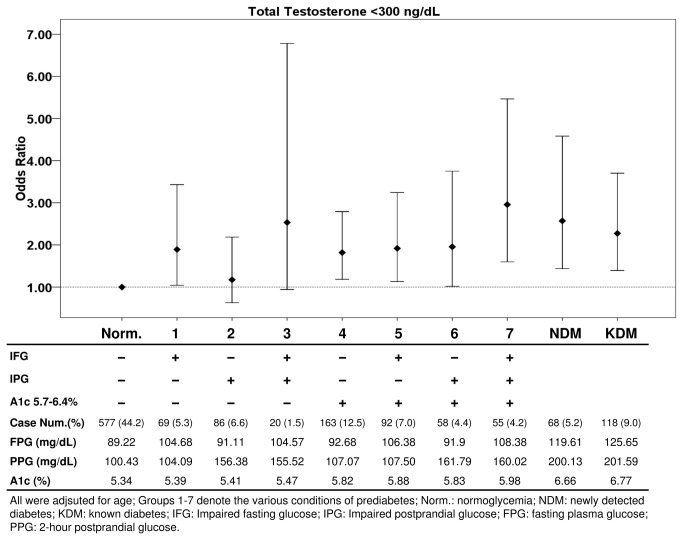
Age-adjusted Odds Ratios for Total Testosterone <300 ng/dL in Various Conditions of Hyperglycemia.